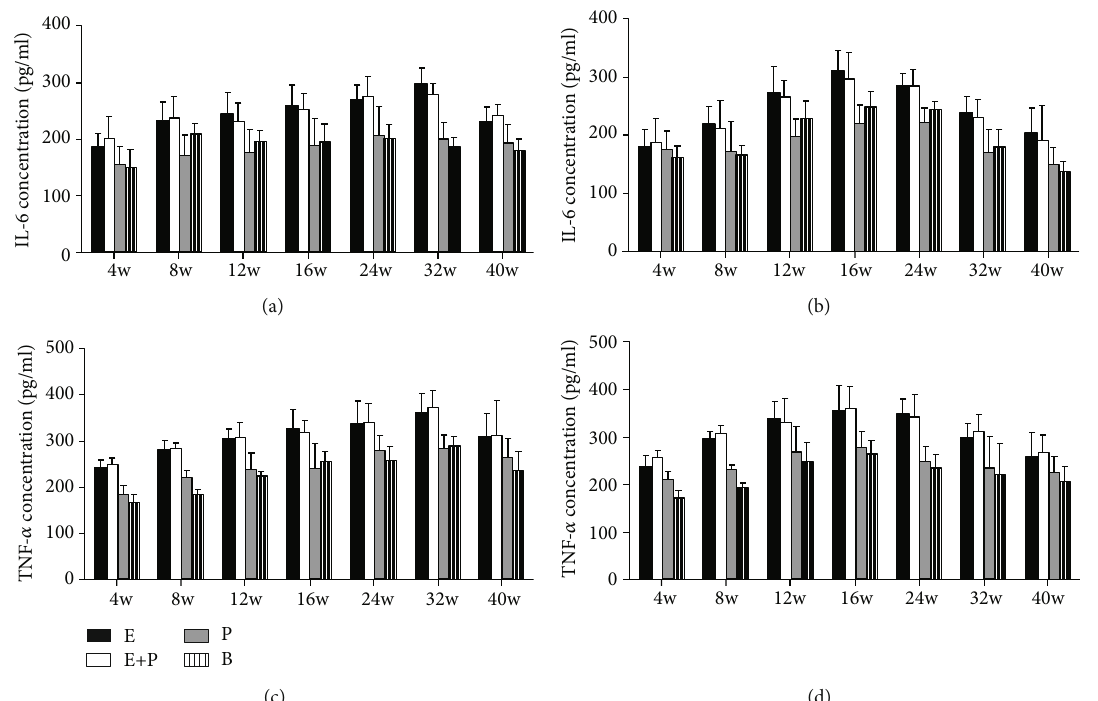
Figure 8: ELISA analysis of IL-6 and TNF- α concentration in di ff erent groups. (a) IL-6 concentration of the left hemisphere. (b) IL-6 concentration of the right hemisphere. (c) TNF- α concentration of the left hemisphere. (d) TNF- α concentration of the right hemisphere. Samples were obtained from rats subjected to di ff erent divisions of CC7 nerve root at 4w, 8 w, 12w, 16 w, 24w, 32 w, and 40w postsurgery. E: entire root group; E+P: entire root+posterior division group; P: posterior division group; B: blank control group. Data are expressed as mean ± SD (one-way ANOVA followed by signi fi cant ( P > 0 : 05 ). Similar results in the right PMC